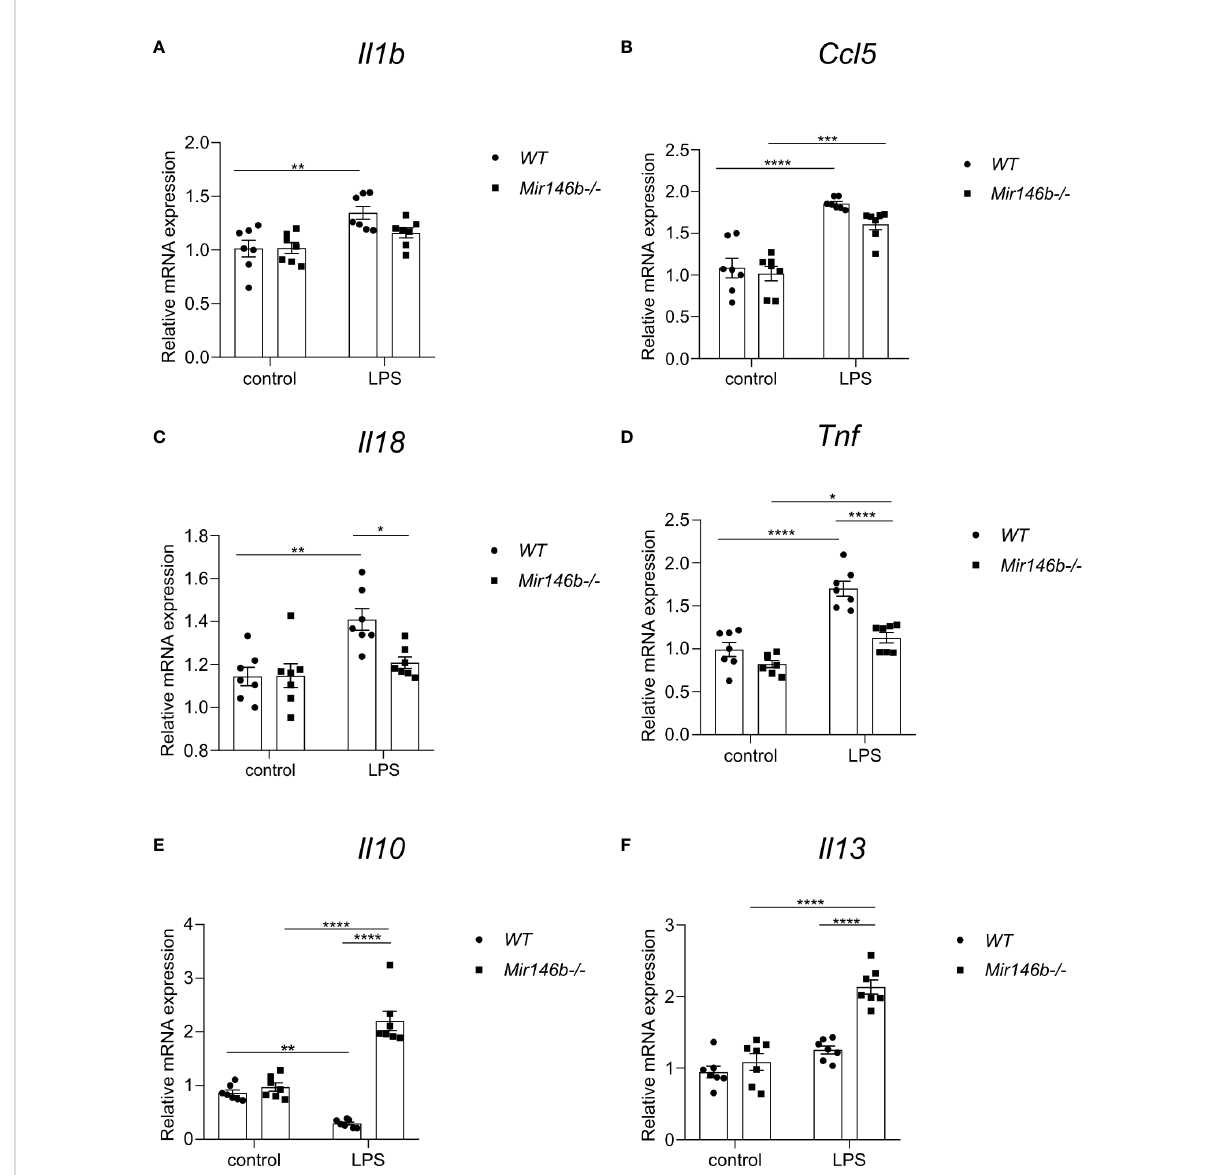
FIGURE 7 Gene expressional changes in the hippocampus of Mir146b-/- mice reveal reduced in fl ammatory response to LPS. Total RNA was puri fi ed from hippocampus of mice injected with LPS in saline or equal volume of saline (control). (A) Relative expression of Il1b (B) Ccl5 (C) Il18 (D) Tnf (E) Il10 and (F) Il13 was analyzed by RT-qPCR with primers for indicated genes. Number of animals = 7. Data represented as mean ± SEM; * p < 0.05, ** p < 0.01, **** p < 0.0001 (Data in panels (A – C, E, F) were analyzed using two-way ANOVA with Tukey ’ s multiple comparisons test; data in panel (D) did not show normal distribution and were transformed into logarithms (Y=log(Y) and further processed using one-way ANOVA with Tukey ’ s multiple comparisons